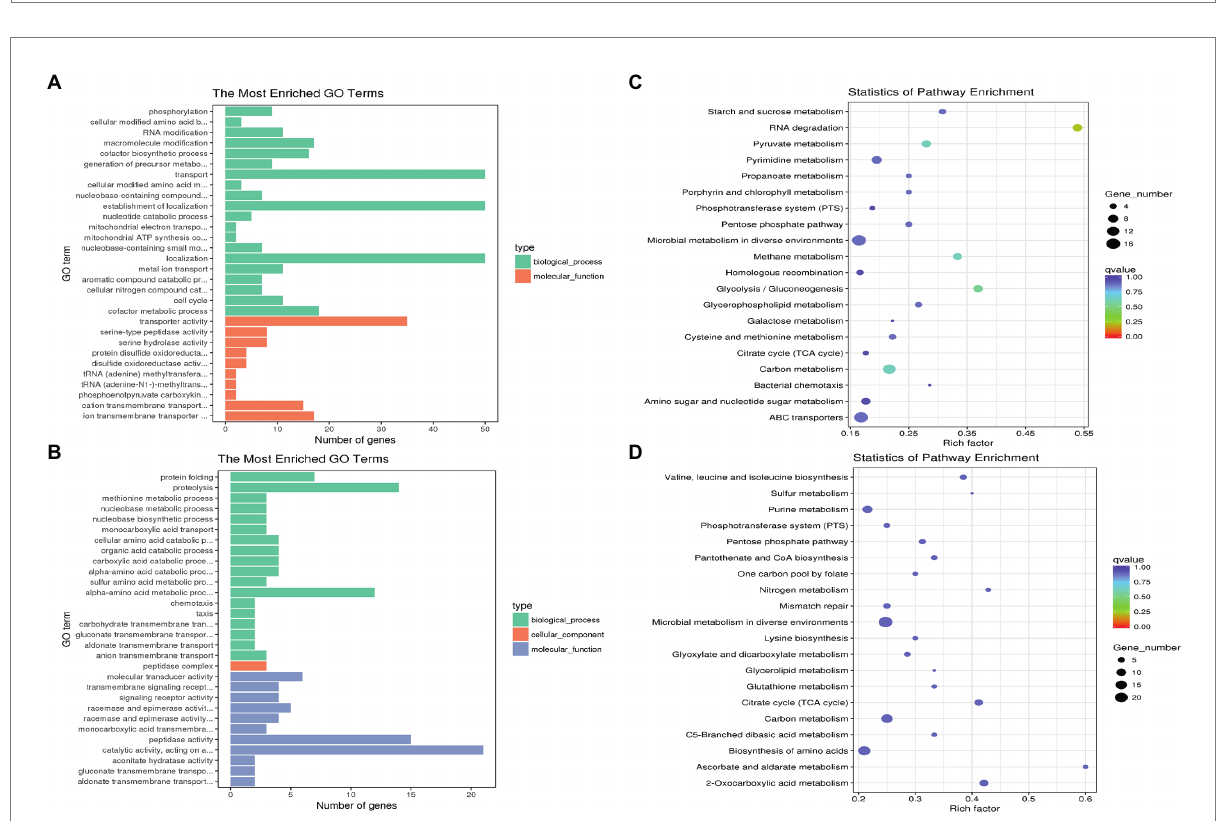
FIGURE 2 GO and KEGG pathway enrichment analysis of differentially expressed genes in Δ luxS and GPS2 groups. The numbers of genes that are up- (A) and down-regulated (B) in Δ luxS versus GPS2 were categorized according to role categories with GO enrichment analysis. KEGG pathway enrichment analysis of Δ luxS versus GPS2 up-regulated (C) and down-regulated (D) differentially expressed genes. The size of each point shows the number of genes in the pathway.